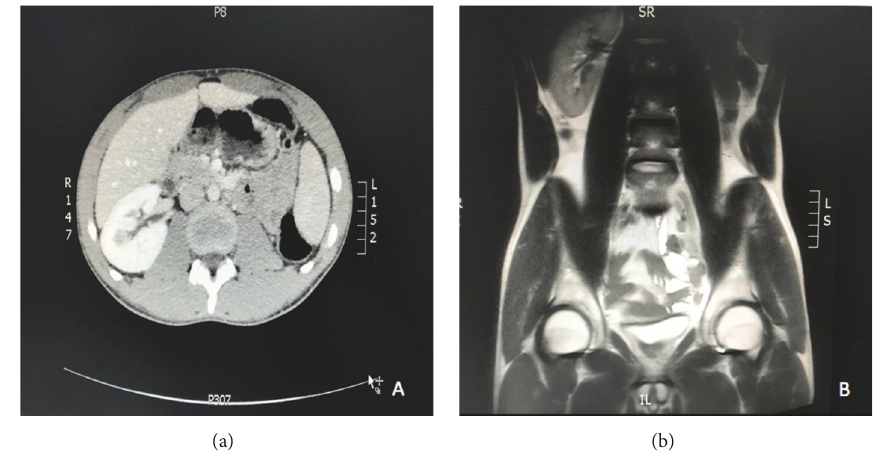
Figure 2: (a) CT axial section showed left renal agenesis. (b) MRI coronal section showed left renal